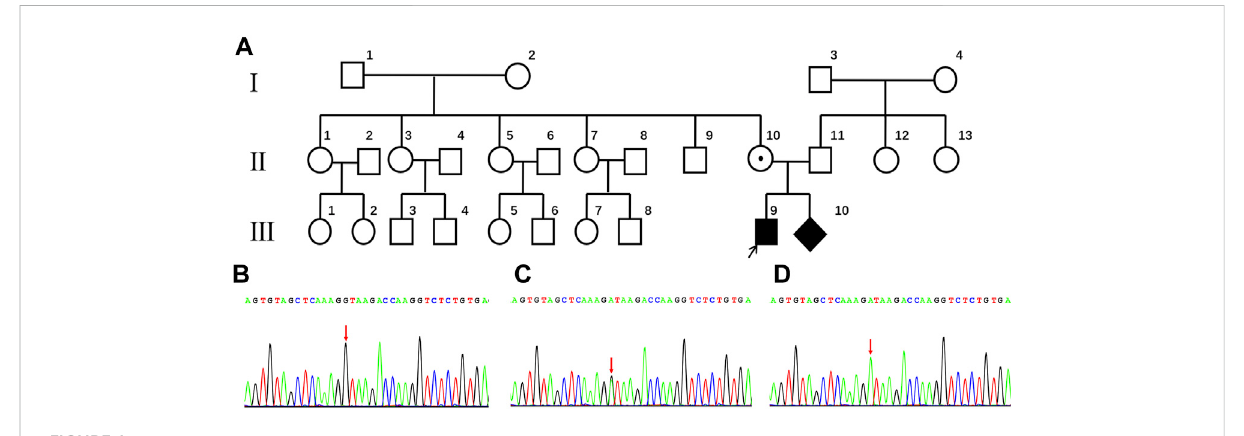
FIGURE 1 (A) Pedigree of the family with Norrie disease. (B) partial wild-type NDP sequences from the family ( Ⅰ -1, Ⅰ -2, Ⅱ -1, Ⅱ -5, Ⅱ -9, Ⅱ -11, Ⅲ -5, and Ⅲ -6). The arrow indicates the proband in this study. (C) partial sequences of the family member heterozygous for the c.174 + 1G > A genotype ( Ⅱ -10).